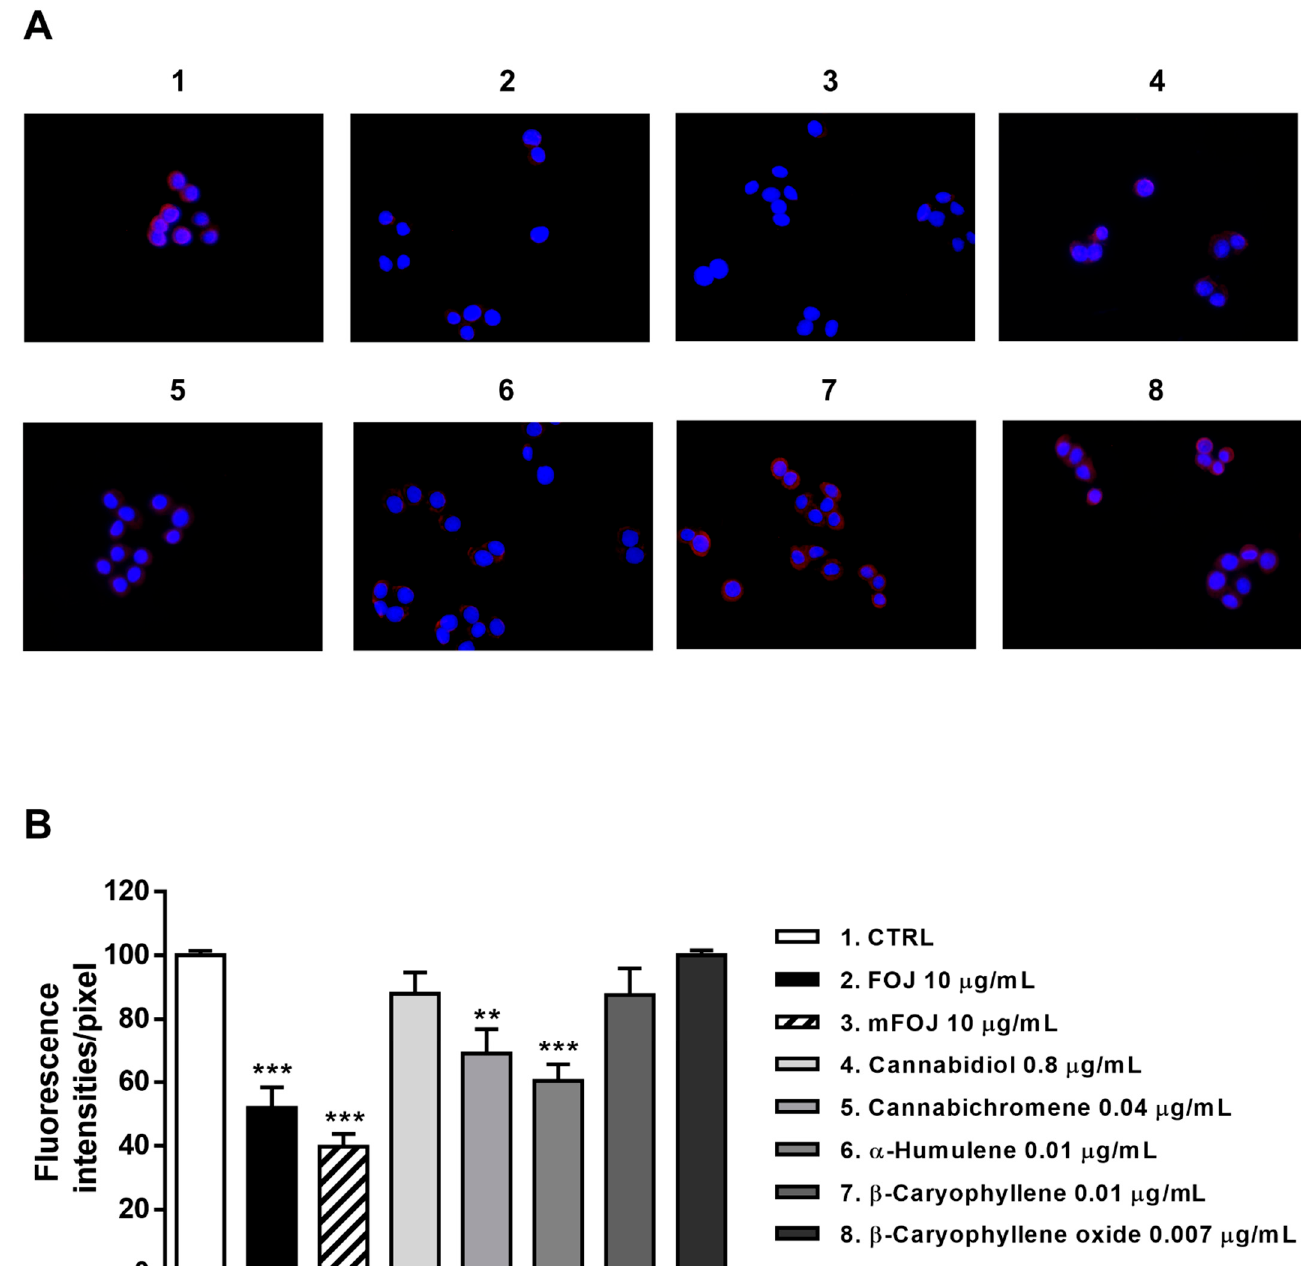
Figure 8. Modulation of CB2 receptor expression in MDA-MB-468 cells detected after 24 h treatment with 10 µg/mL FOJ (organic extract from Felina 32 hemp inflorescences collected in June), the corresponding mFOJ cocktail, and with the nonintoxicating phytocannabinoids and caryophyllane sesquiterpenes contained in FOJ extract. ( A ) Representative images obtained at immunofluorescence analysis. ( B ) Densitometric analysis of immunofluorescence carried out by the free soft- ware ImageJ ( n = 6). ** p < 0.01 and *** p < 0.001, significant difference respect to the control (ANOVA + Dunnett’s Multiple Comparison PostTest). 1. Control; 2. FOJ; 3. mFOJ; 4. Cannabidiol, 0.8 µg/mL; 5. Cannabichromene, 0.04 µg/mL; 6. α - Humulene, 0.01 µg/mL; 7. β -Caryophyllene, 0.01 µg/mL; 8. β -Caryophyllene oxide, 0.007 µg/mL.